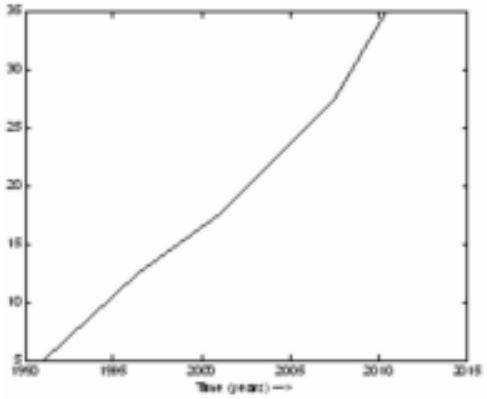
Figure 14: Trend of IEC for future